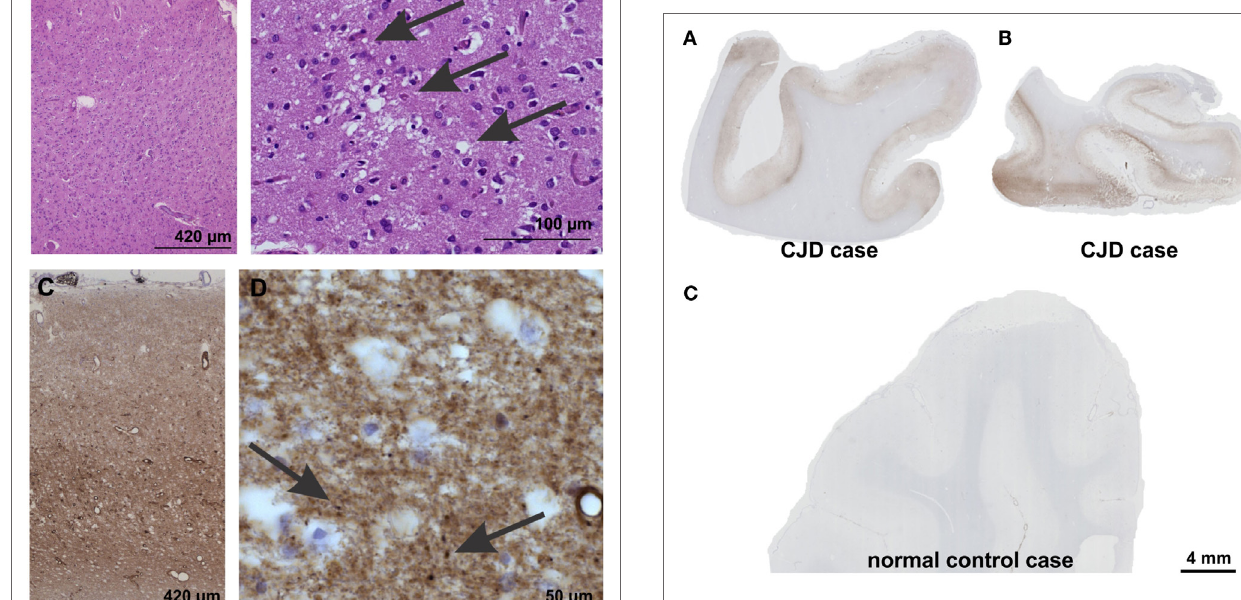
FIguRe 3 | Presence of pathological prion protein proven by the detection of proteinase K-stable prion-protein aggregates in the frontal cortex (a) and the medial temporal lobe with the hippocampal formation (B) of the patient. In the control case, physiological prion protein was digested completely by proteinase K and the cortex showed no labeling (C) . Prion protein antibody used: 3F4, proteinase K, and formic acid pretreatment, 1/100, Dako-Agilent, Santa-Clara, CA, USA. Calibration bar in (C) valid for (a,B) . Comment on the distribution pattern of pathological prion protein. Pathological, proteinase K-stable prion protein was found in the neo- and allocortex and in the striatum whereas these deposits as well as the spongiform changes were less abundant in the cerebellum. This distribution pattern can be found in codon 129 VV1 type patients